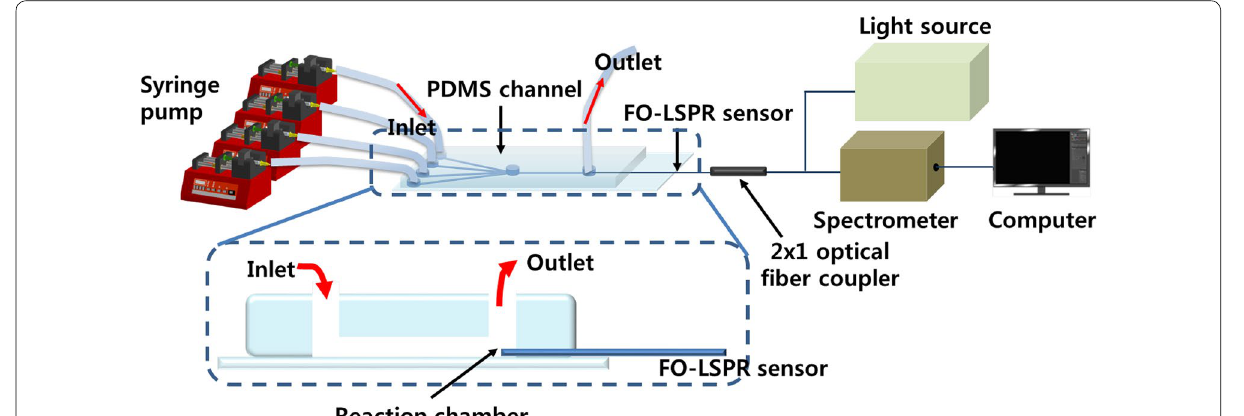
Fig. 3 Schematic diagram of the FO‑LSPR sensor measurement system